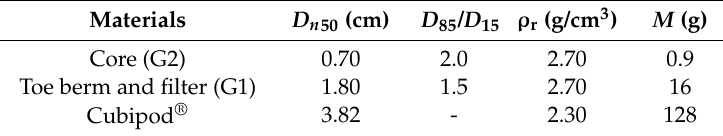
Table 1. Characteristics of the tested